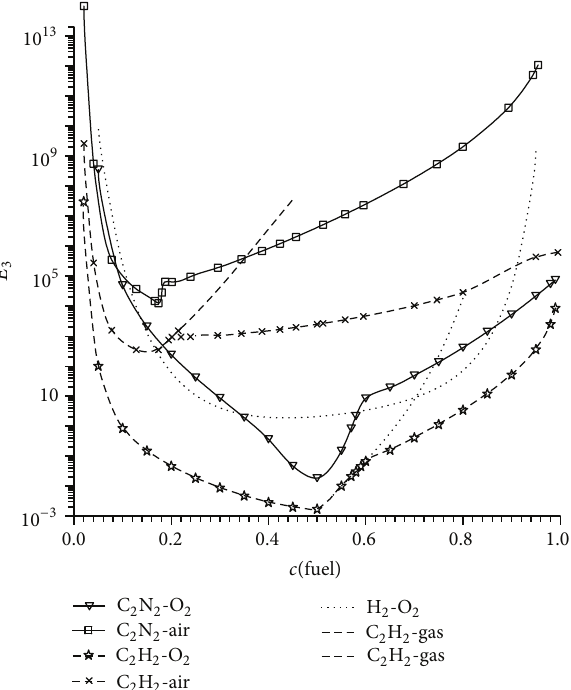
Figure 21: The graphical BANK of data about critical initiation energy of spherical DW (J) on fuel molar concentration for different mixtures, which allow to compare mixtures on its detonation hazards. Doubled lines for C 2 H 2 correspond to cases of gaseous and solid C atoms in detonation